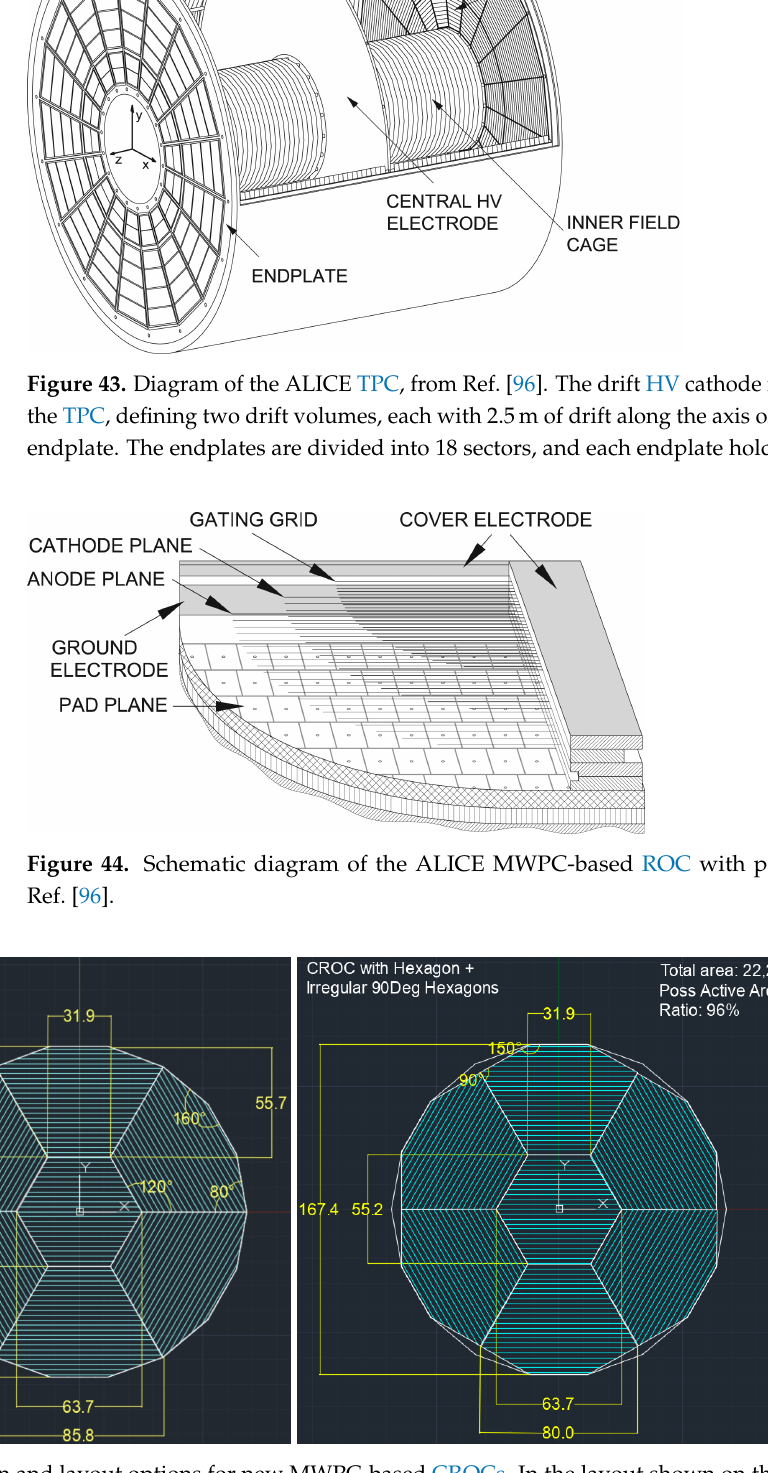
Figure 45. Possible design and layout options for new MWPC-based CROCs. In the layout shown on the left, the irregular hexagons fill the full central hole, with wires intersecting the chamber walls at an 80 degree angle. In the layout shown on the right, some corners of the chambers are constrained to 90 degrees, leading to a 4% loss in